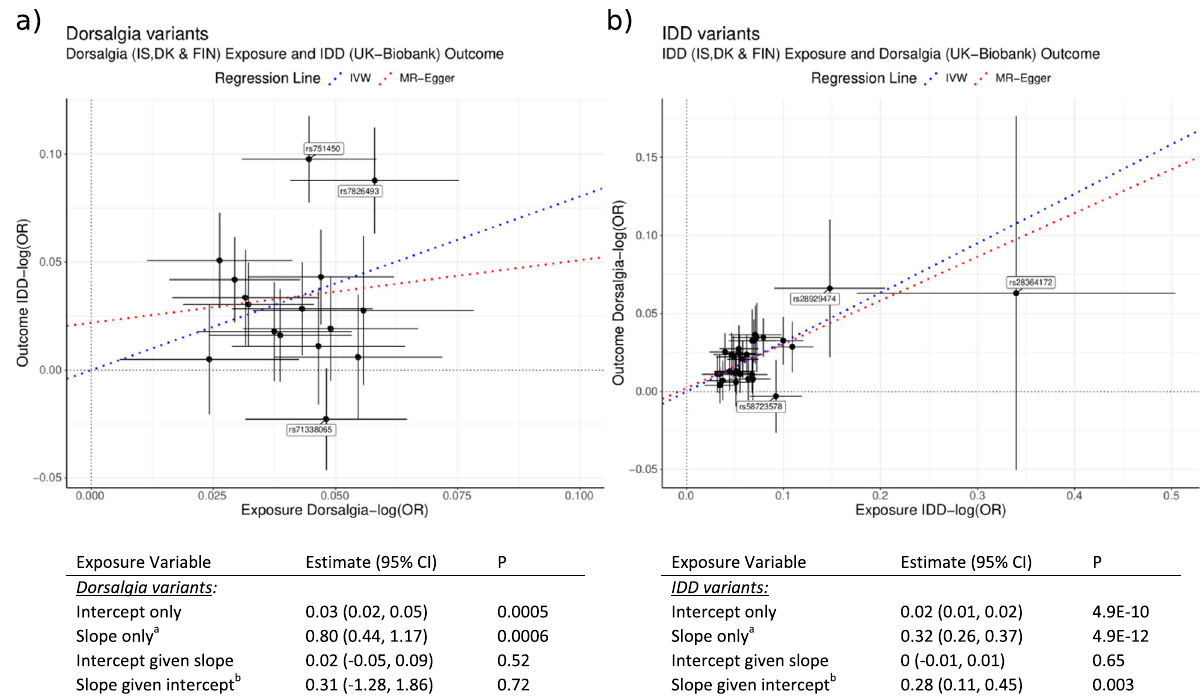
Fig. 3 Mendelian randomization (MR) analyses of the genetic relationship between IDD and dorsalgia in terms of causality. a shows effects of variants associating with Dorsalgia at genome-wide signi fi cance, on IDD and dorsalgia. b shows the effects of variants associating with IDD at genome-wide signi fi cance, on IDD and dorsalgia. Effects are expressed as logarithms of odds ratios (log(OR)) and black crosses indicate 95% con fi dence intervals (CI) around effects. To avoid sample overlap, exposure effects are from the cohorts from Iceland (IS), Denmark (DK) and Finland (FIN), while outcome effects are from UK-Biobank. The dashed blue lines show the linear regression fi t through the origin, weighting variants according to the square of the standard error of their effect estimates (also known as inverse-variance weighted, IVW) a) ). The IVW-MR method is a multiplicative random effects model, where the test statistic is from a t-distribution, the test is two sided. No multiple comparison adjustments were made. The dashed red lines show the weighted linear regression fi t not constrained to go through the origin (also known as MR Egger b) ). For the IDD variants, the slopes of both regression lines are different from zero. For the dorsalgia variants, the slope of the regression line (IVW) through the origin is different from zero, but not the slope of the unconstrained regression line (MR Egger). Further, the effects of the dorsalgia variants deviate substantially more from the regression lines than the IDD variants. These results are not sensitive to outlier removal (Methods, Supplementary Fig.